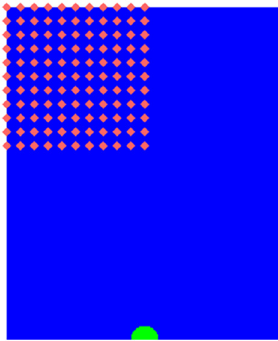
Figure 4. Finite element simulation model diagram.